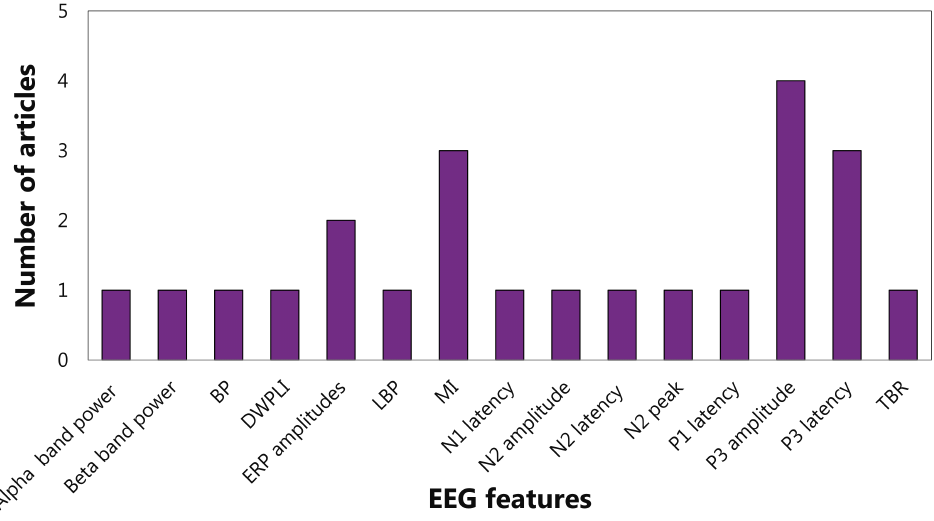
Figure 15. EEG features for inhibition emerged from highest quality articles. Table 3. The five top scored articles according to the field-weighted citation impact metric by Scopus (the higher, the best). For each article, the normalized QATQS Score is also reported (the lower, the better). The normalized QATQS Score is computed as the ratio between the global quality score of the article and the number of quality components considered. FWCI: field-weighted citation